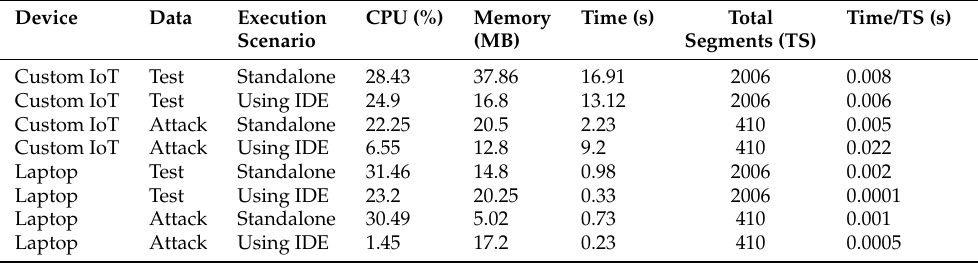
Table 6. Performance analysis of the proposed